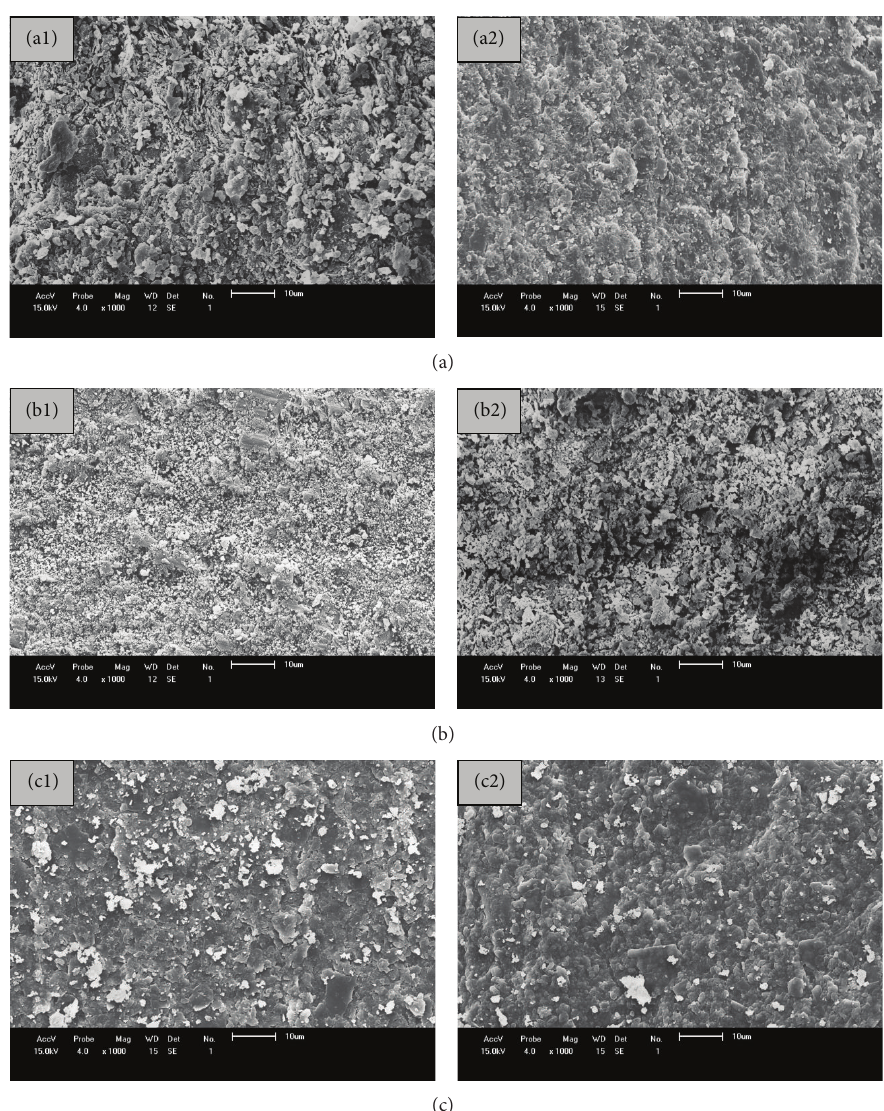
Figure 3: SEM images of longitudinal (1) and transversal (2) sections of the sintered ceramic membranes at 900 (a), 1000 (b), and 1100 ∘ C